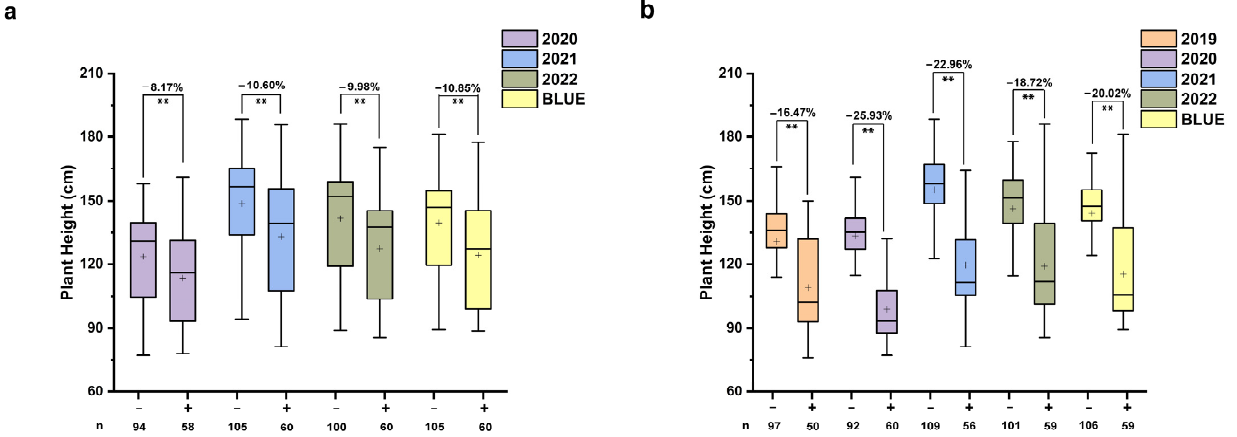
Figure 4. Effect of QPH.nwafu-2B.2 ( a ) and QPH.nwafu-6A.1 ( b ) on plant height (PH). + and − represent lines with the alleles from the Icaro and Y4 of the target locus, respectively; n represent lines with the corresponding alleles, ** significant at the level of p < 0.01.